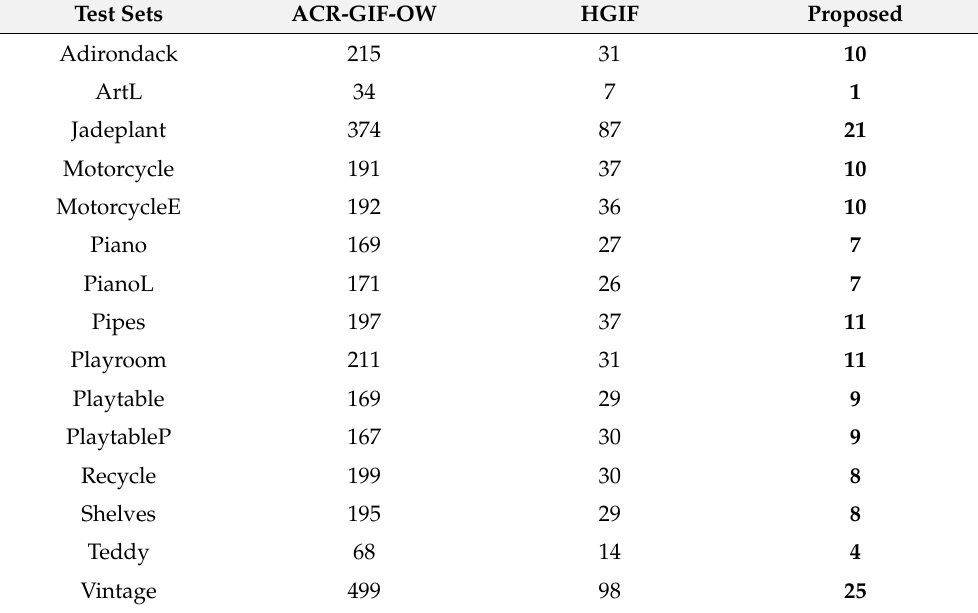
Table 4. Comparison of the running time of each algorithm for a pair of rectified images (s). These computations were executed in MATLAB 2017b using an Intel Core I5 8300H and 16 GB